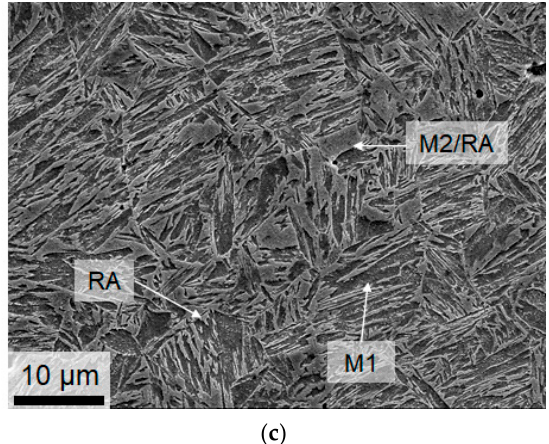
Figure 7. SEM micrographs after the QP process at ( a ) QP-321, ( b ) QP-371, ( c ) QP-421 s. M1 stands for tempered martensite, M2 for fresh martensite, and RA for retained austenite.